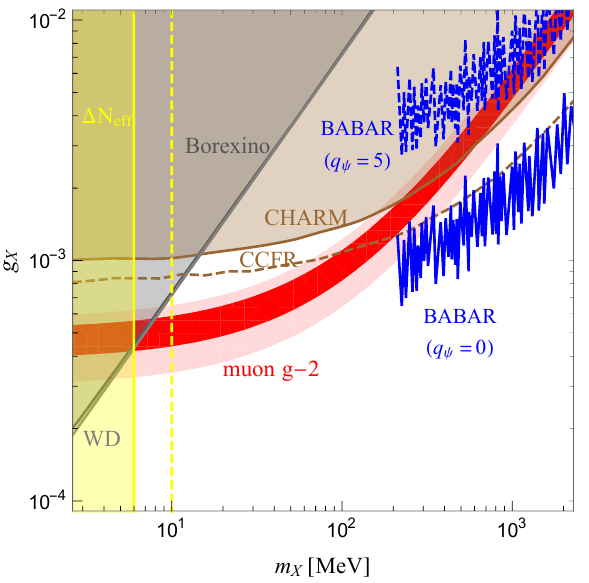
Figure 1 . Constraints on the X boson and muon g (cid:0) 2 favored region. Dark (light) red region is favored the muon g (cid:0) 2 at 1 (cid:27) (2 (cid:27) ) level. The other colored regions and lines show regions excluded by the various experimental and astrophysical